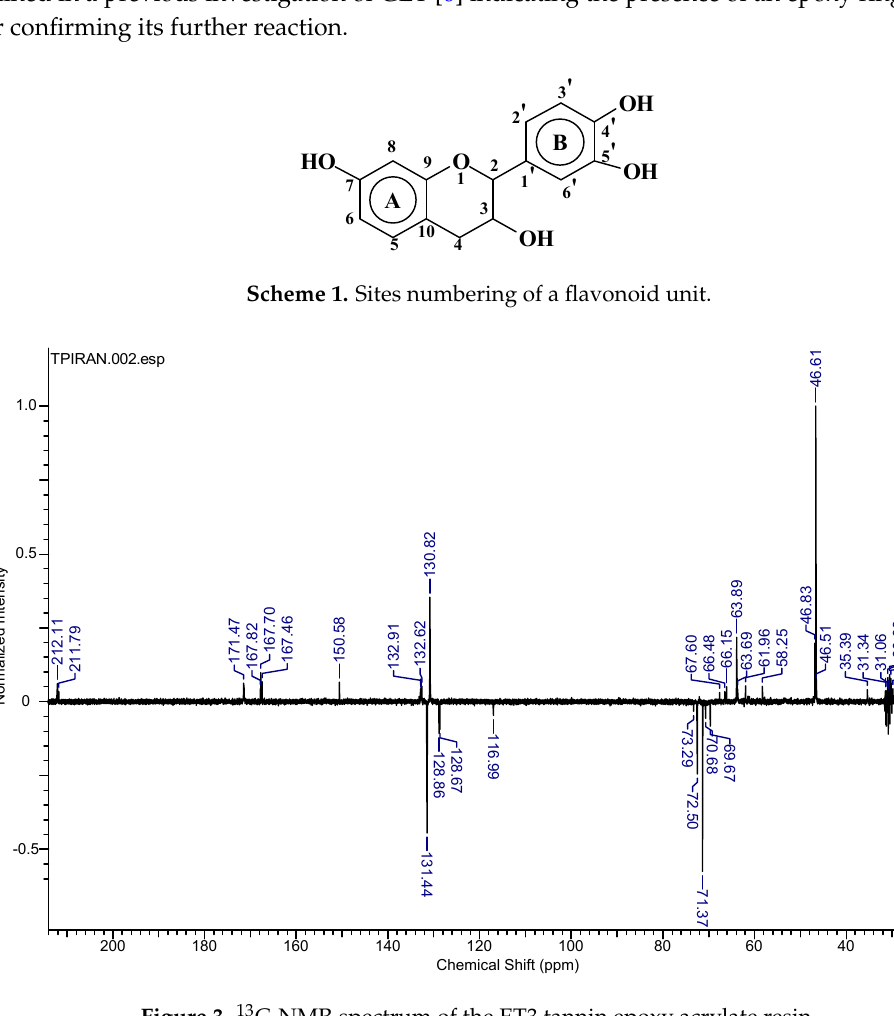
Figure 3. 13 C-NMR spectrum of the ET3 tannin epoxy acrylate resin.